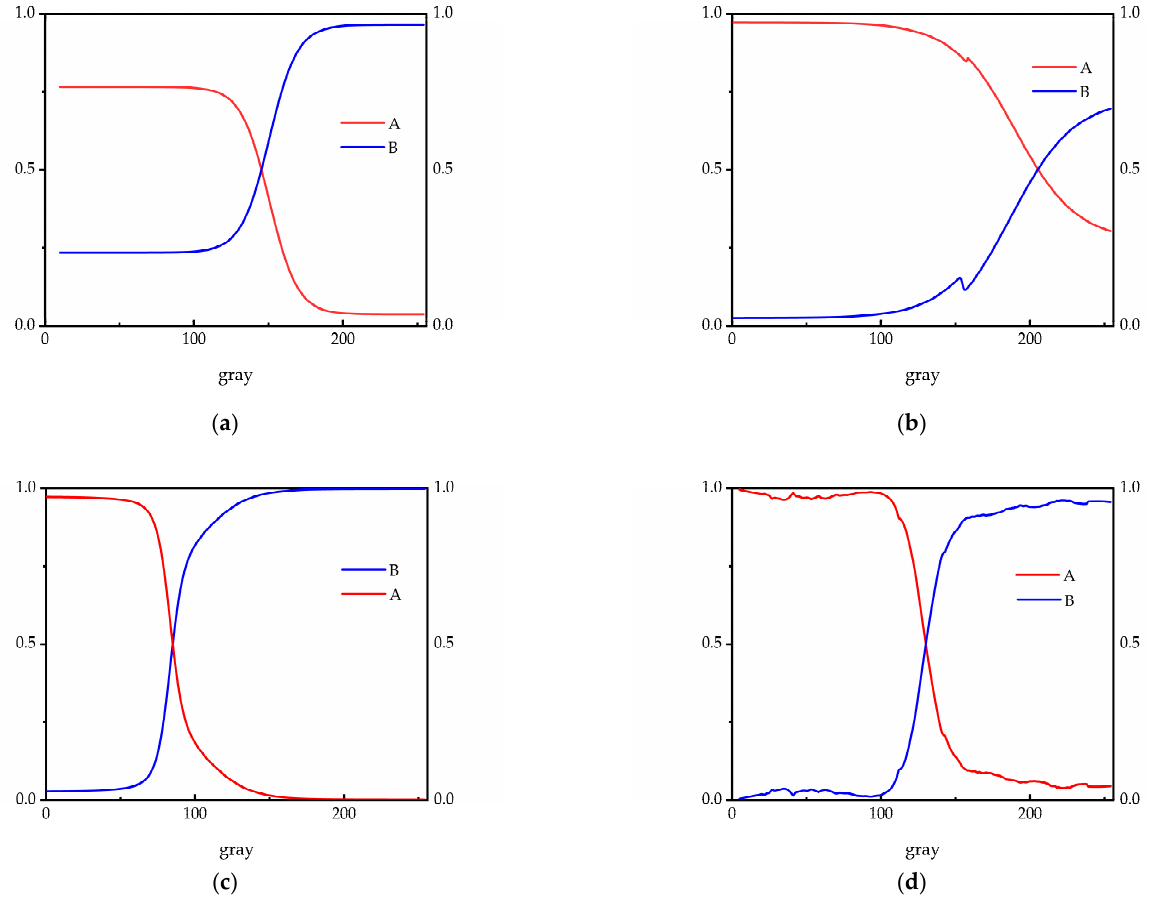
Figure 3. The possibility distribution function of feature: ( a ) HD; ( b ) IN; ( c ) FE; ( d ) NDVI.